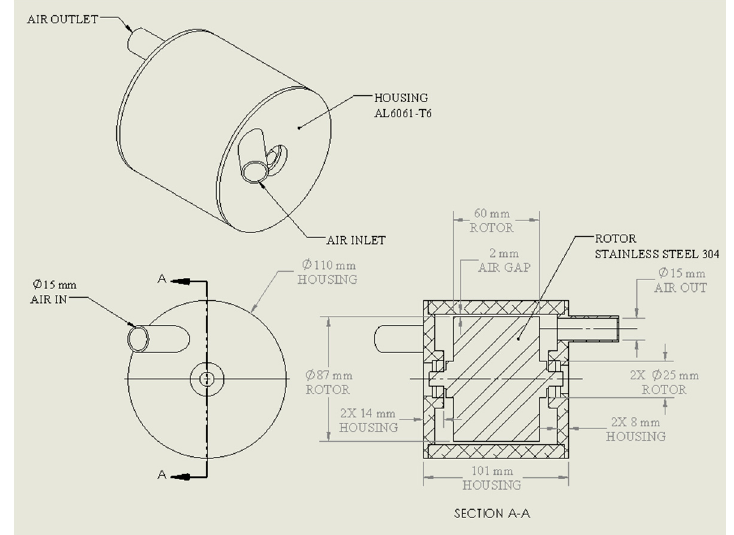
Figure 3. Experimental apparatus rotor sub-assembly.